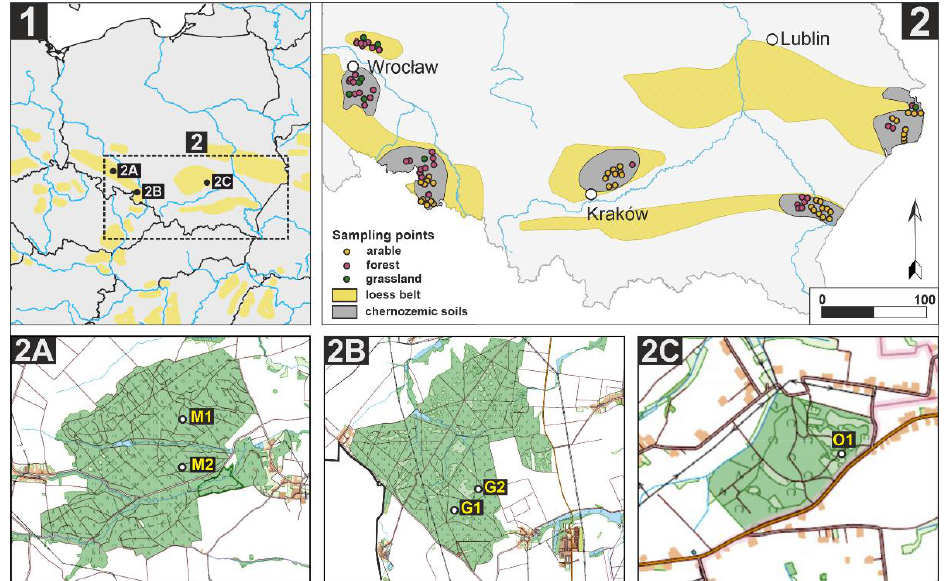
Figure 1. ( 1 ) Map of the study area in south Poland with: ( 2 ) sampling points of arable, grassland and forest locations, used to create the spectral database, ( 2A ) sampled barrows in the Muszkowice Forest: M1 (site: Muszkowice 18), M2 (site: Muszkowice 45), ( 2B ) sampled barrows in the Głubczyce Forest: G1 (site: Lwowiany 22) and G2 (site: Lwowiany 23), and ( 2C ) the sampled barrow (O1) in Ostrów near the Proszowice Plateau (site: Ostrów 1).